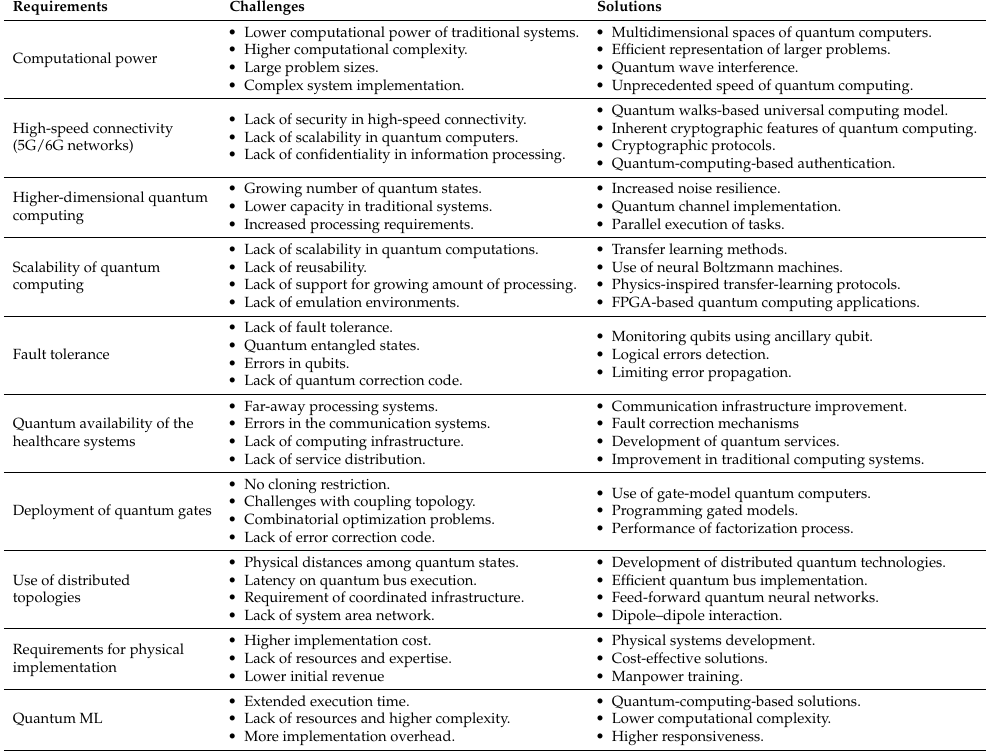
Table 3. A summary of key requirements of quantum computing for healthcare services provisioning along with different challenges and